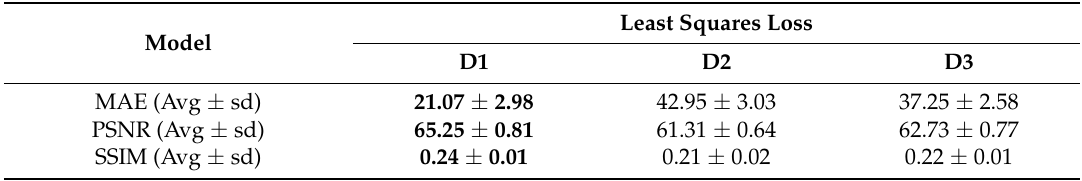
Table 3. Comparison of the MAE, PSNR, and SSIM for different discriminator networks and least squares loss. The leading scores are displayed in bold